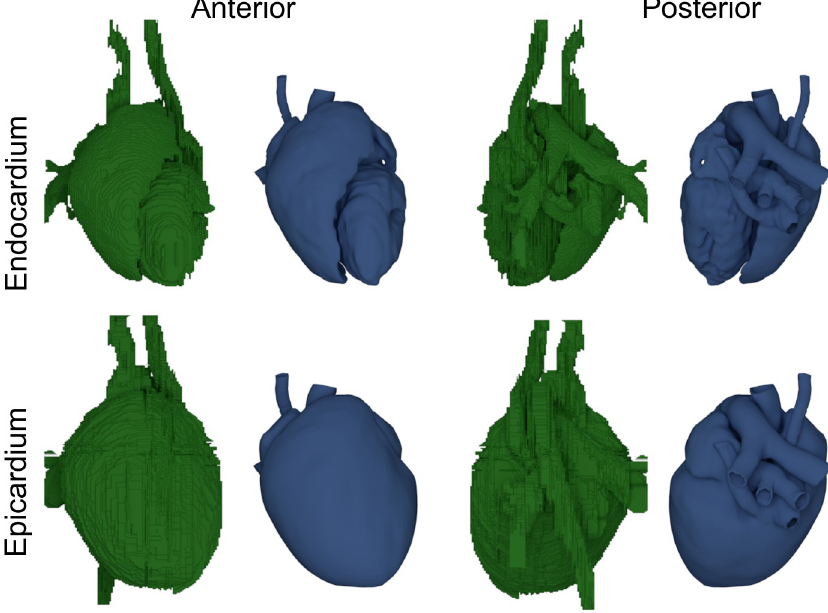
Fig 2. Surfaces of the initial segmented heart (green) and the resulting processed smoothed surfaces (blue). Anterior and posterior view of the initially segmented surfaces (using Seg3D2 [17]) of endo-, and epicardium and the resulting retopologized smooth surfaces (using Blender [18] and InstantMeshes [19]).